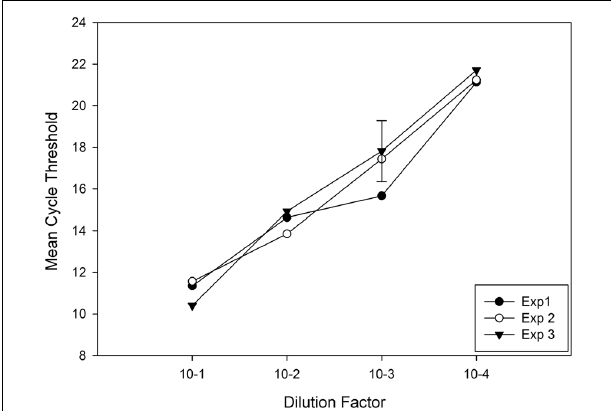
FIGURE 2 | Cycle threshold (CT) means representing three real-time qPCR experiments for elongation factor 1- α , ef1 α , (primers EF4F and EF4R) amplifying DNA template (diluted 1/1000 µ L H 2 O) generated from PCR (primers EF3F and EF5R) of Beauveria bassiana mixed into Zea mays DNA, prepared prior in a 10-fold dilution series, to determine consistency between PCR experiments and replicates. A 5% least significant difference (LSD) bar compares PCR experiments and replicates for significance.